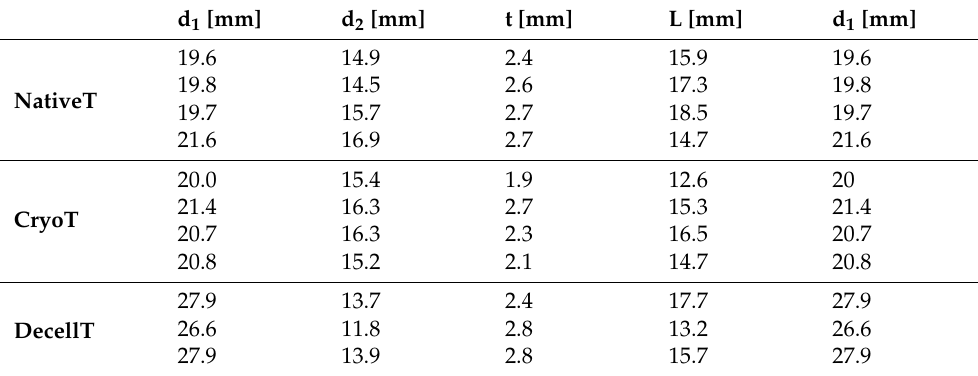
Table 1. Size of DecellT, CryoT and NativeT samples.